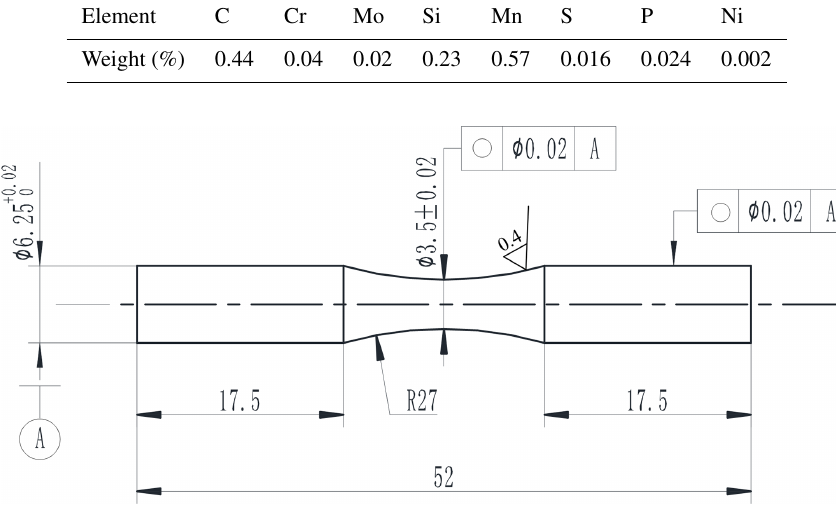
Figure 1. Fatigue specimen geometry (dimensions in mm).